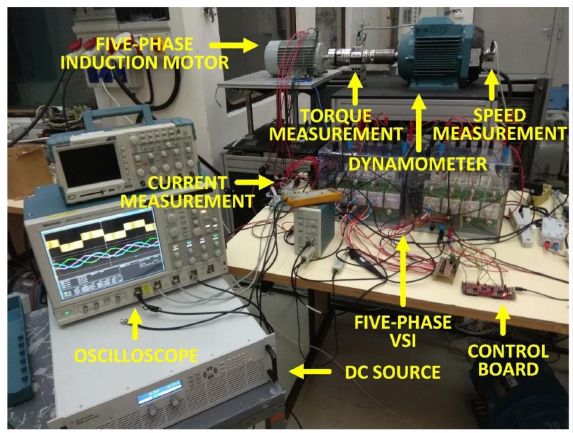
Figure 35. Measurement of a five-phase induction motor in fault conditions.